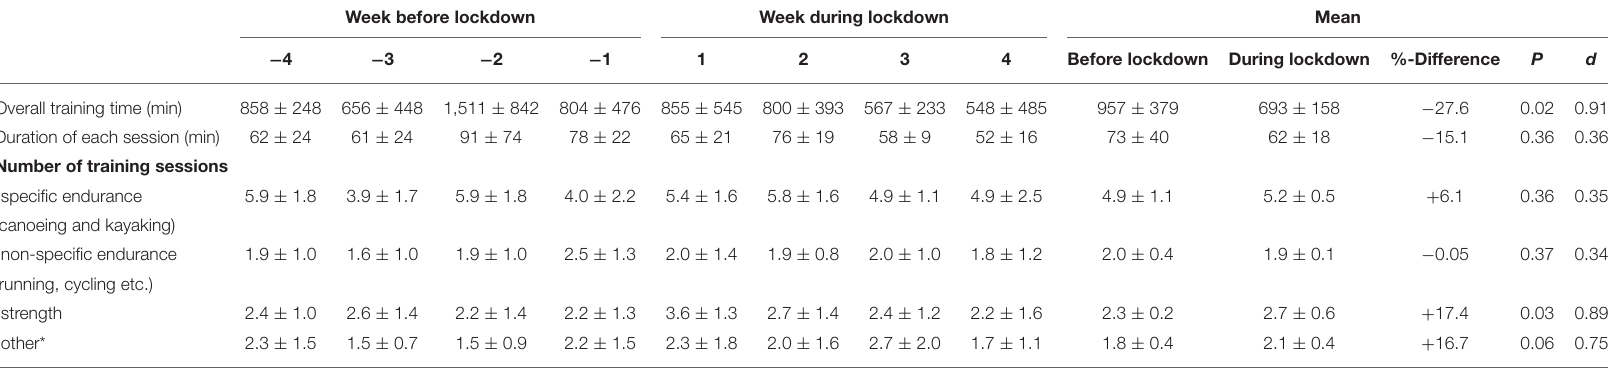
TABLE 2 | Numbers of training sessions, overall training time and duration of each session during the 4 weeks prior to and the initial 4 weeks of lockdown. Week before lockdown Week during lockdown Before lockdown During lockdown %-Difference